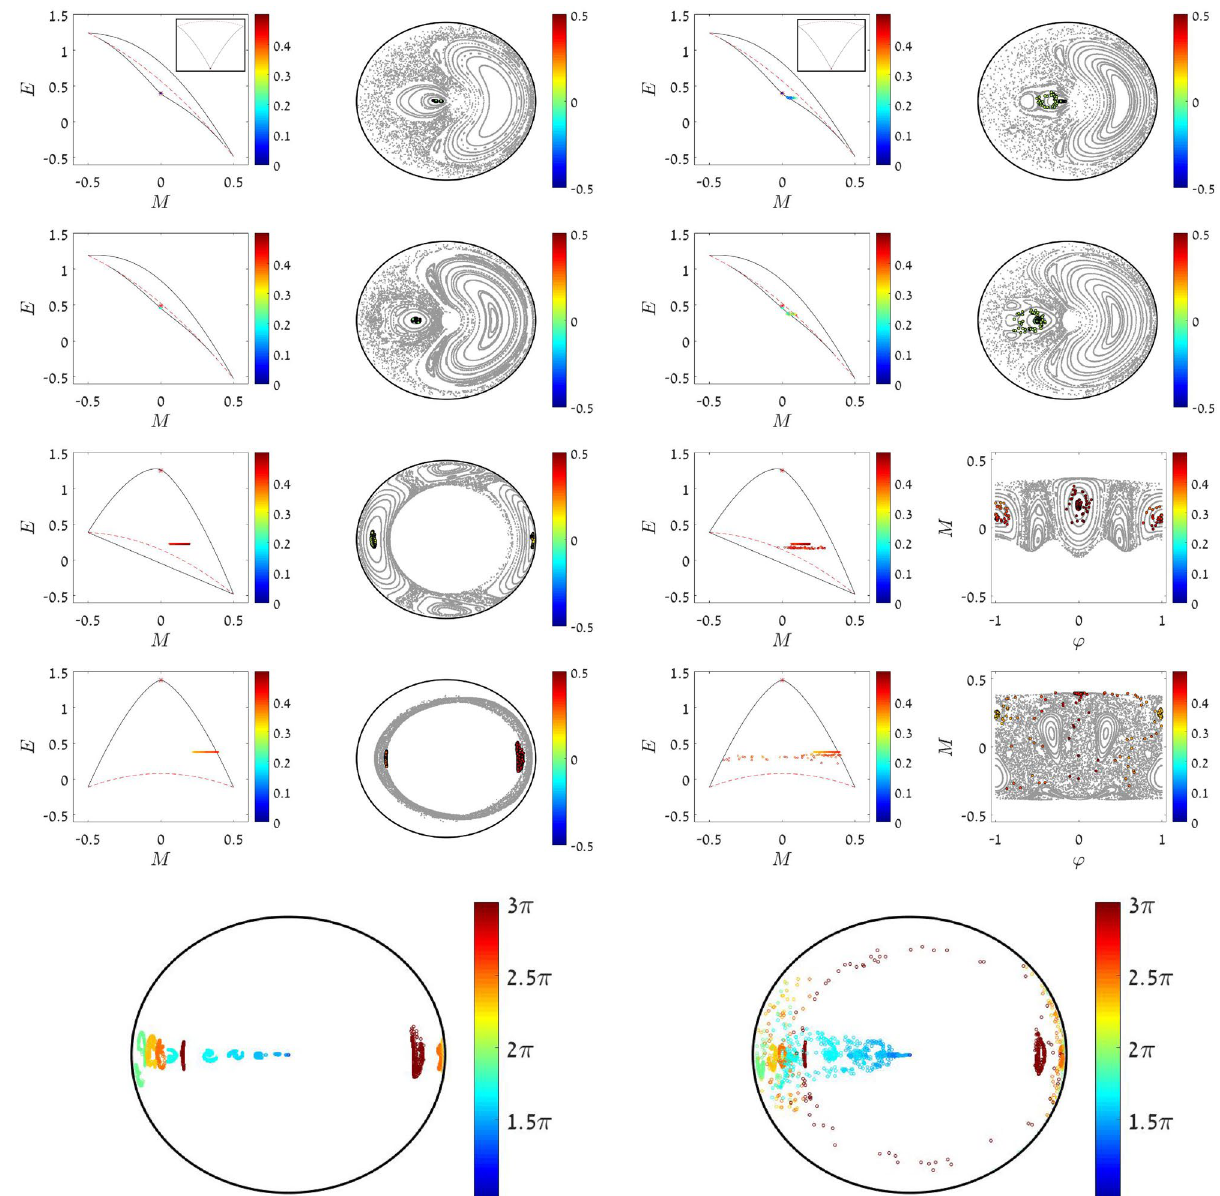
5 π 10 − 4 (left Figure 7. Phase space perspective for the simulations of a sweep process. The rates are ˙ � = · 2.3 . The initial preparation is a 3 π 10 − 4 (right set of panels). The interaction is u set of panels) and ˙ � = = · 0 (represented by a red star). Initially it is the minimum of the energy landscape (see insets). condensate at n = 1.51 π , 1.6 π , 2.5 π , 3 π , where the central SP in no longer a Snapshots are taken after (cid:31) dyn is crossed, at � = local minimum, and furthermore it is dynamically unstable. Consequently the cloud is free to spread away from n M 0 . First column of each set: snapshots of the evolving cloud in ( E , M ) space, where the points are color- = = coded by n . Second column of each set: The cloud points, color-coded by M , are overlayed on the (ϕ , n ) Poincare section. Two panels use non-polar (ϕ , M ) coordinates for enhanced resolution. Bottom of each set: the evolving cloud in (ϕ , n ) Poincare coordinates. Snapshots of the cloud are taken at different moments, and are color-coded by (cid:31) . Blue is the initial cloud, and red is its final several branches as explained previously. Most of it is re-trapped by quasi-integrable tori. But at the very last moment most of the tori are destroyed, and chaos takes-over again. Consequently a fraction of the cloud, that is no longer locked by tori, undergoes post-sweep ergodization.